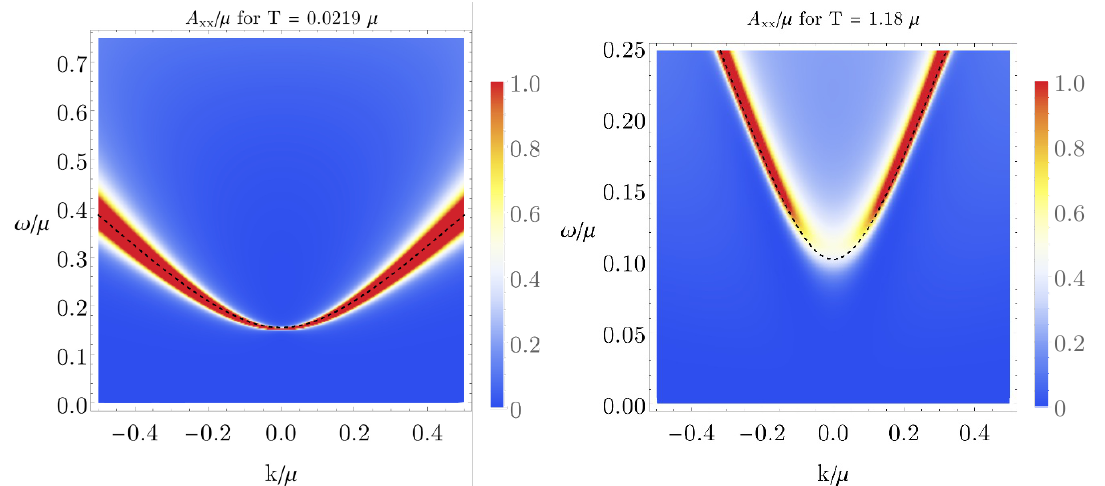
Figure 5. The current spectral function for T ’ 0 : 02 (cid:22) (left) and T ’ 1 : 18 (cid:22) (right) with a double- trace deformation ( (cid:11) 2 = 1 = 25). Here we can clearly see the gapped plasmon mode, as the height of the peak does not go to zero as k ! 0